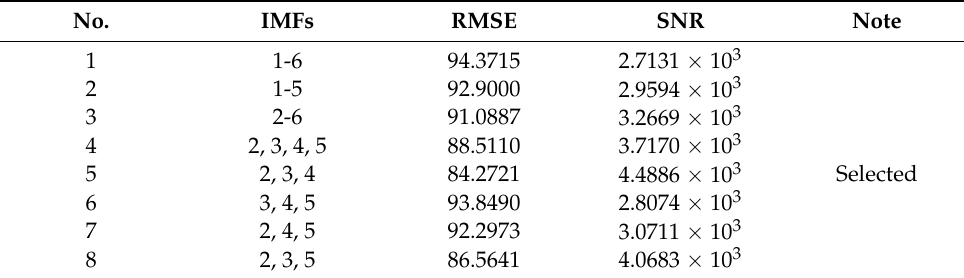
Figure 7. IMFs after VMD decomposition: ( a ) − ( f ) show IMF1 − IMF6, respectively. Table 1. RMSE and SNR of different IMFs combinations.